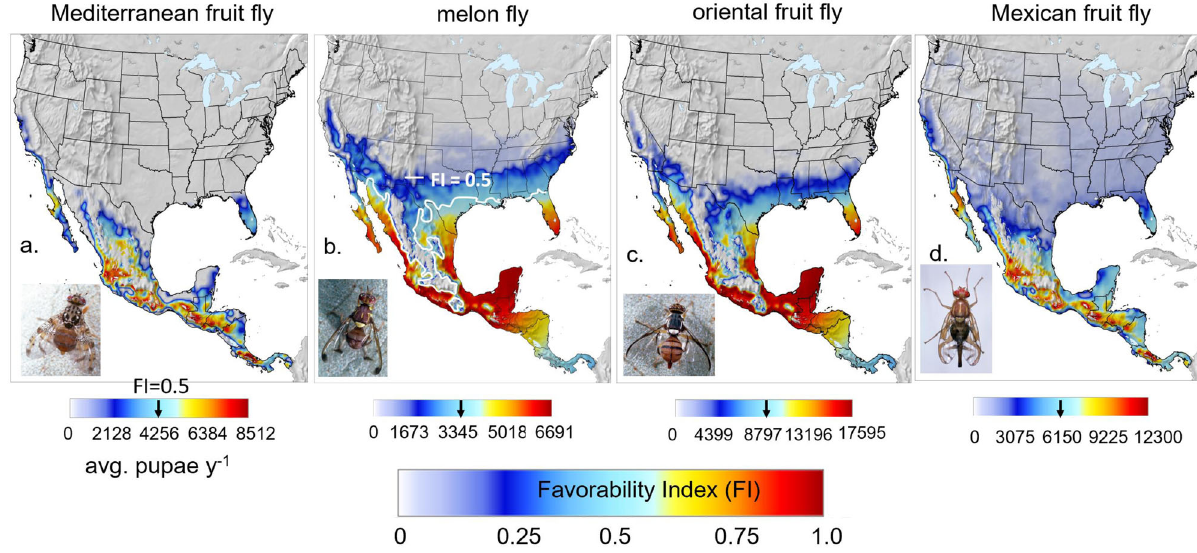
Fig. 2 Prospective average distribution and relative abundance (average annual sum of pupae) in North and Central America during 1980 – 1990. a Mediterranean fruit fl y, b melon fl y with the FI = 0.5 isocline indicated in white, c oriental fruit fl y, and d Mexican fruit fl y (detailed maps in Supplementary Figs. S1, S2, S5, S6). Clips of the tropical fruit fl ies are by Jack Kelly Clark, University of California Statewide IPM Program.